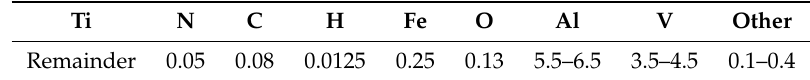
Table 2. Chemical composition of Ti6Al4V alloy [2].